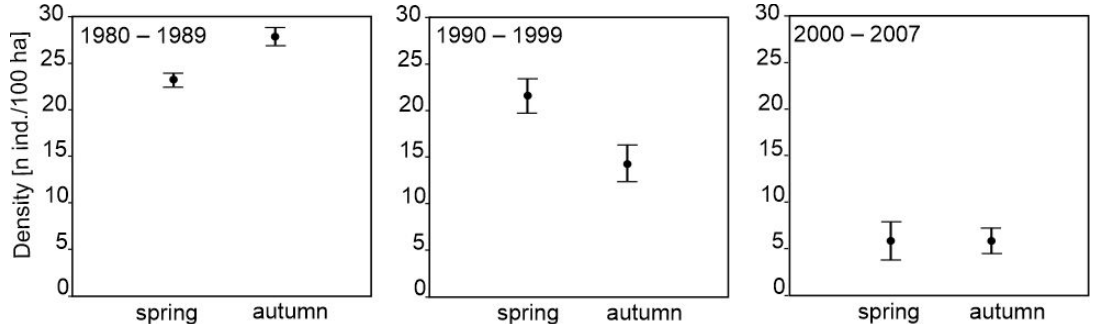
Figure 3. Decrease in the annual hunting bag of brown hare in the study area (Rog ó w, central Poland).